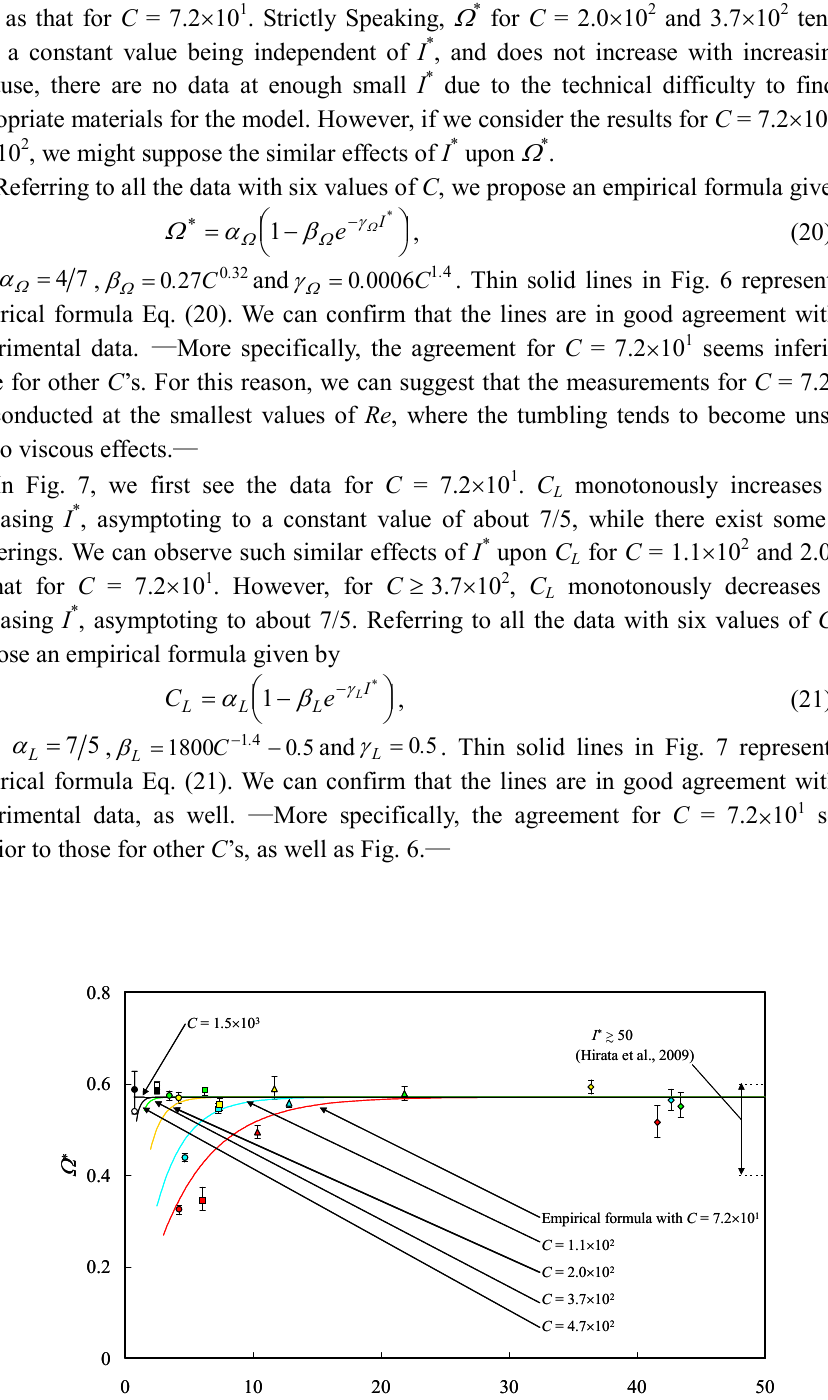
. Thin solid lines in Fig. 6 represent this